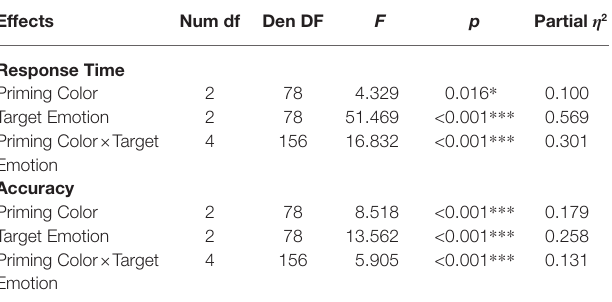
TABLE 2 | Statistical results of repeated measures ANOVAs in experiment 1 (color priming task).